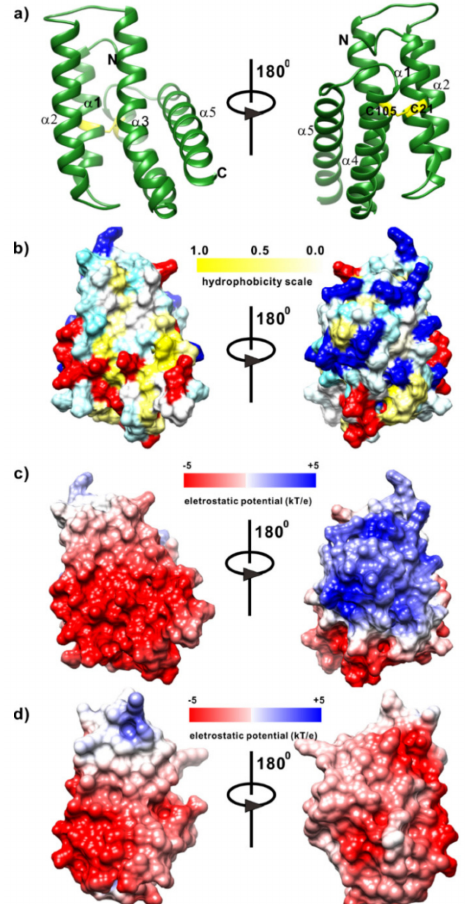
Figure 4. Ribbon ( a ), hydrophobicity ( b ), and surface charge potential ( c ) representations of AcSpN monomer, and surface charge potential representation of MaSpN from NA ( d ). Disulfide between C21 and C105 is indicated by yellow sticks in ( a ). Red and blue colors represent negatively and positively charged residues, respectively, in ( b